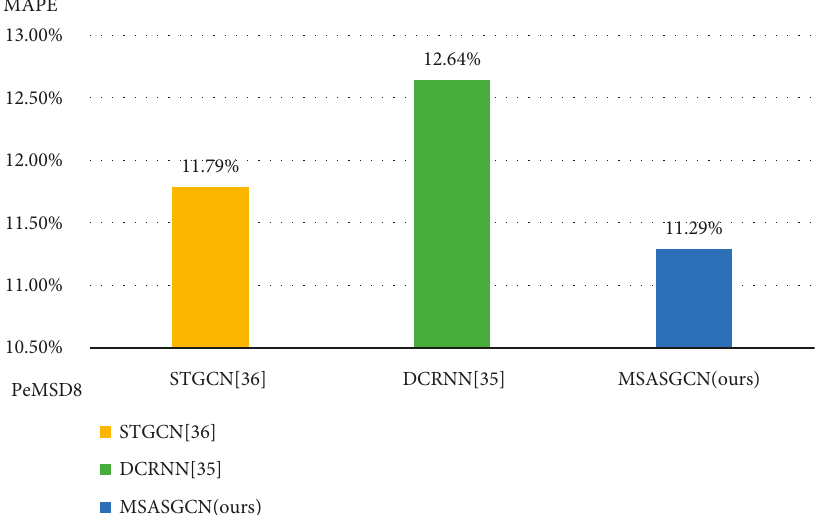
Figure 7: Comparison of different algorithms MAPE on PeMSD8. Table 5: Introduction of the model name.